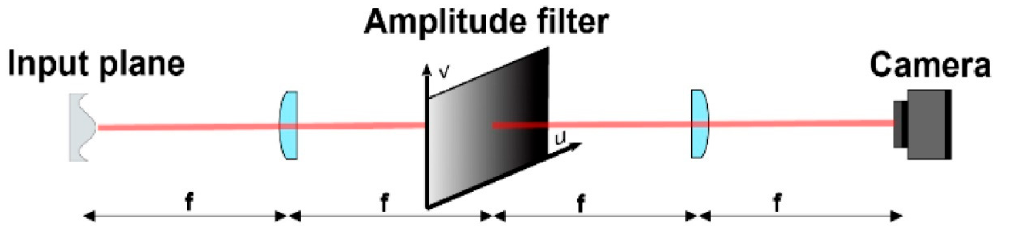
Figure 4. Principle of optical differentiation WF sensor. A filter with linear field transmission gradient is located at the Fourier plane of a 4f line. Figure reused from Ref. [28] under the terms of the OSA Open Access Publishing Agreement, © 2019 Optical Society of America.